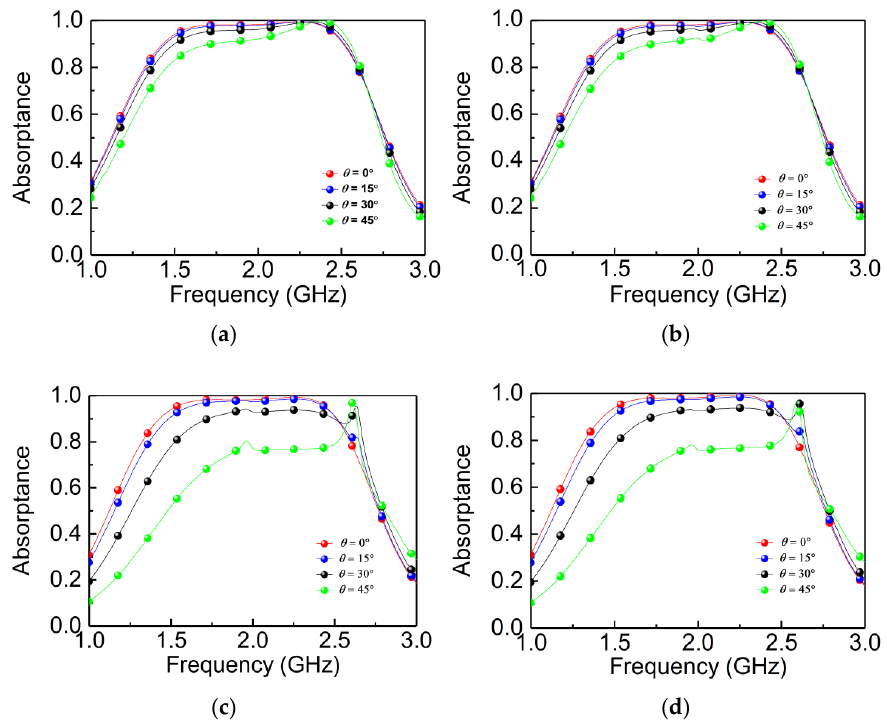
Figure 3. Absorptance with different oblique incidence. ( a ) Absorptance under TE wave along the − z direction; ( b ) absorptance under TE wave along the +z direction; ( c ) absorptance under TM wave along the − z direction; ( d ) absorptance under TM wave along the +z direction.